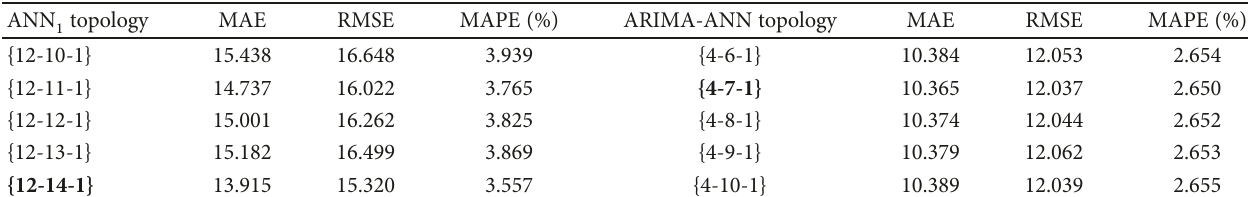
Table 3: Forecasting measurements for two ANN designs (rice price